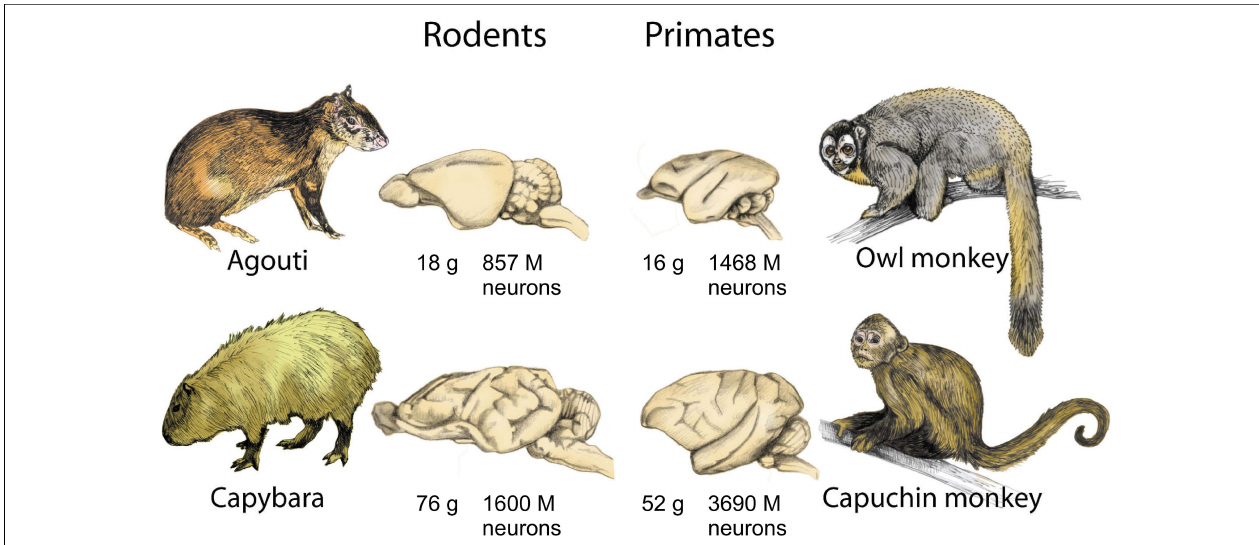
FIGURE 4 | Brain size is not a reliable indicator of number of neurons across orders. Because of the different cellular scaling rules that apply to rodent and primate brains, primates always concentrate larger numbers of neurons in the brain than rodents of a similar, or even larger, brain size. Data from Herculano-Houzel et al. (2006, 2007). Illustration by Lorena